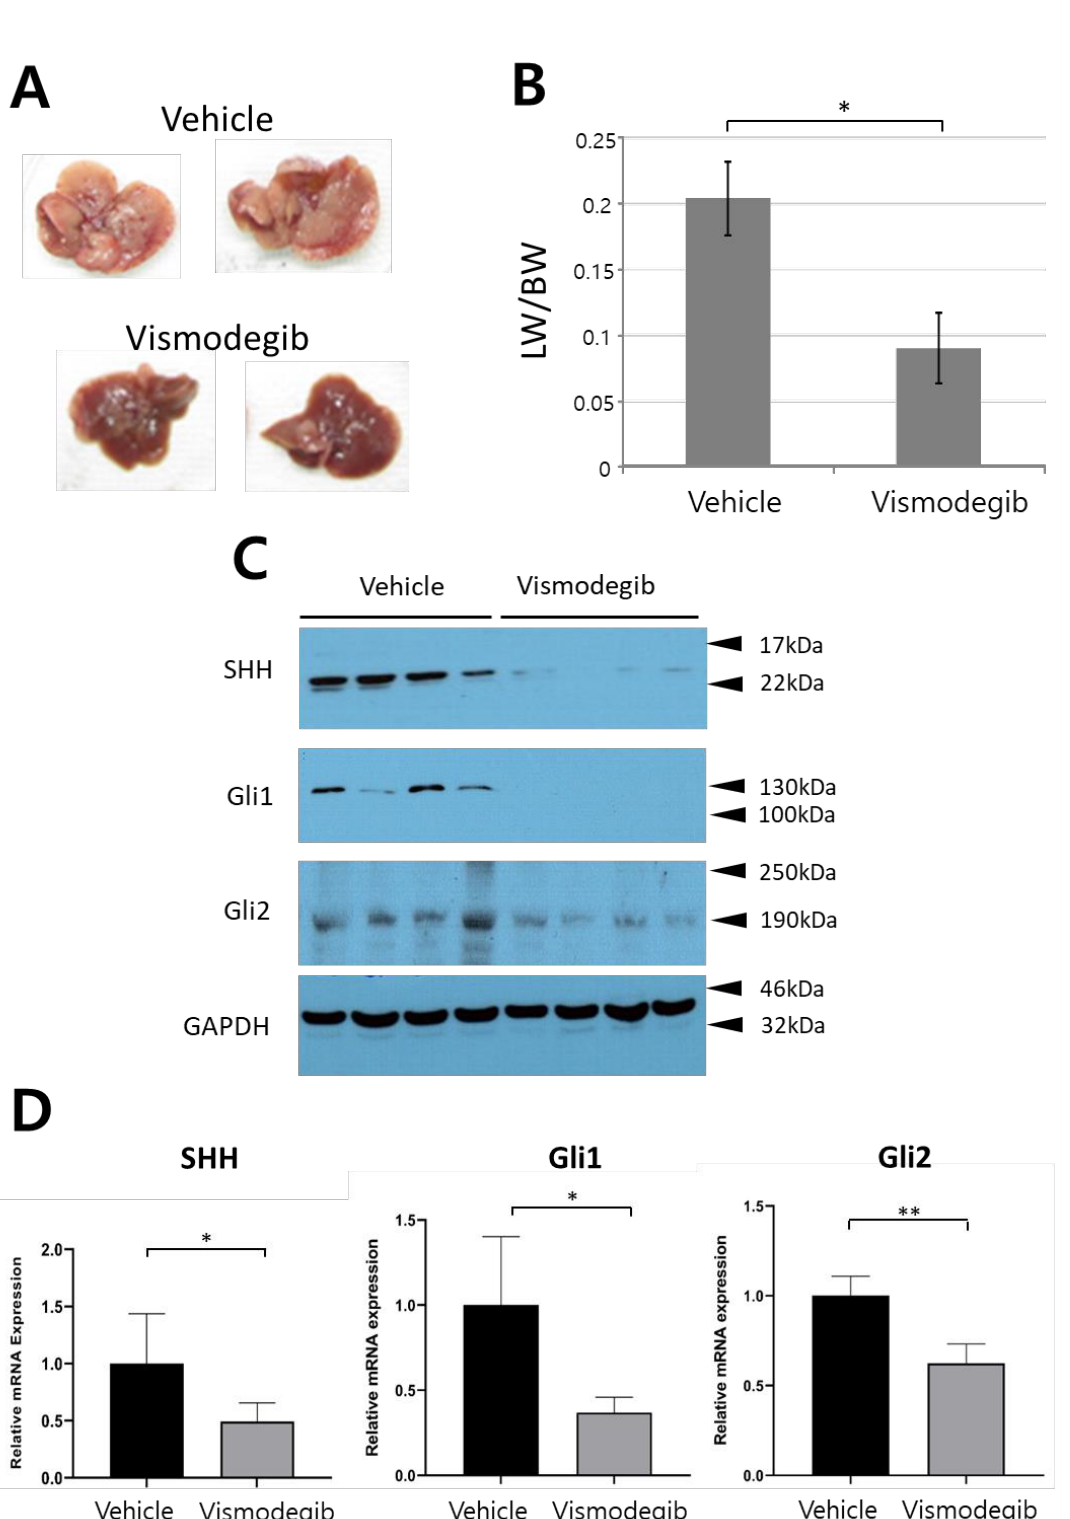
Figure 6. Vismodegib treatment suppressed CCC. ( A ) Gross morphology of representative livers of mice treated with vehicle and vismodegib. ( B ) Liver weight/body weight (LW/BW) ratios of mice treated with vehicle and vismodegib. The graph represents the mean ± SEM ( n = 5 livers per group) (*, p < 0.05). Western blots ( C ) and quantitative RT-PCR ( D ) showing expression levels of SHH, Gli1, and Gli2 in livers of indicated groups (*, p < 0.05; **, p < 0.01).